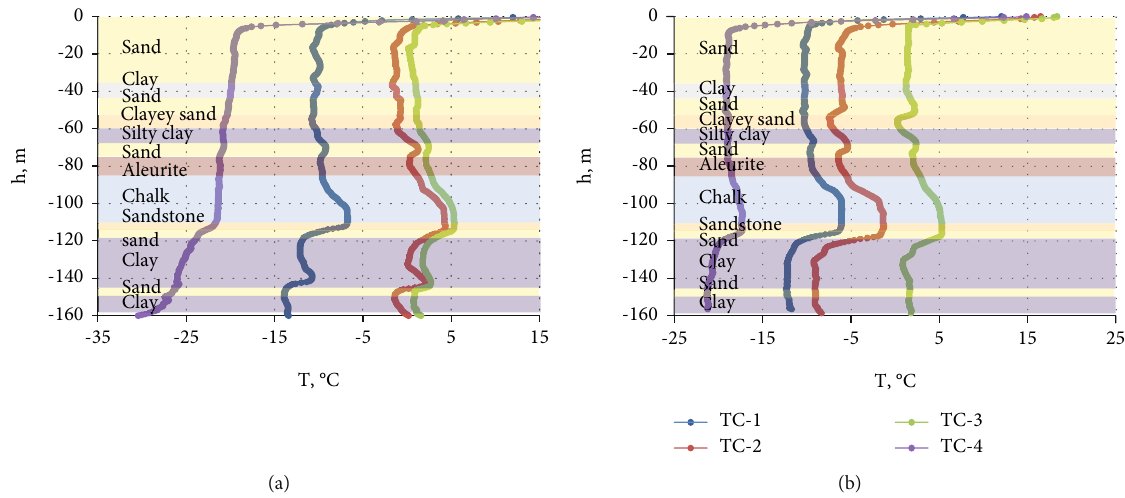
Figure 4: Temperature pro fi les in TC boreholes of shafts no. 1 (a) and no. 2 (b) at the time point of 100